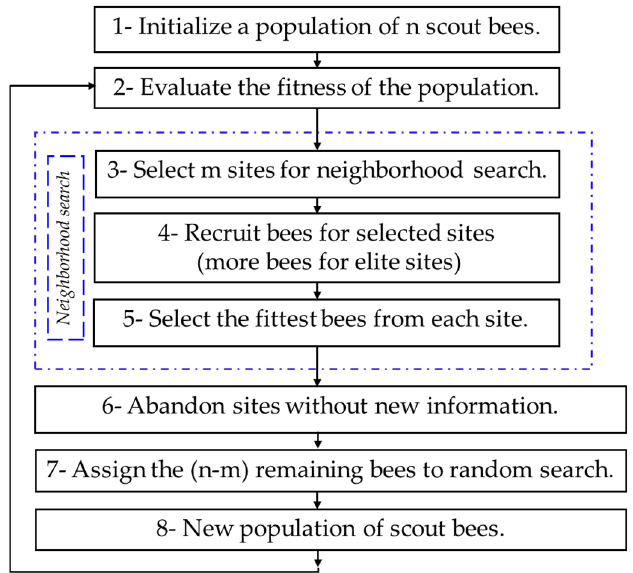
Figure 5. The Bees Algorithm flowchart.